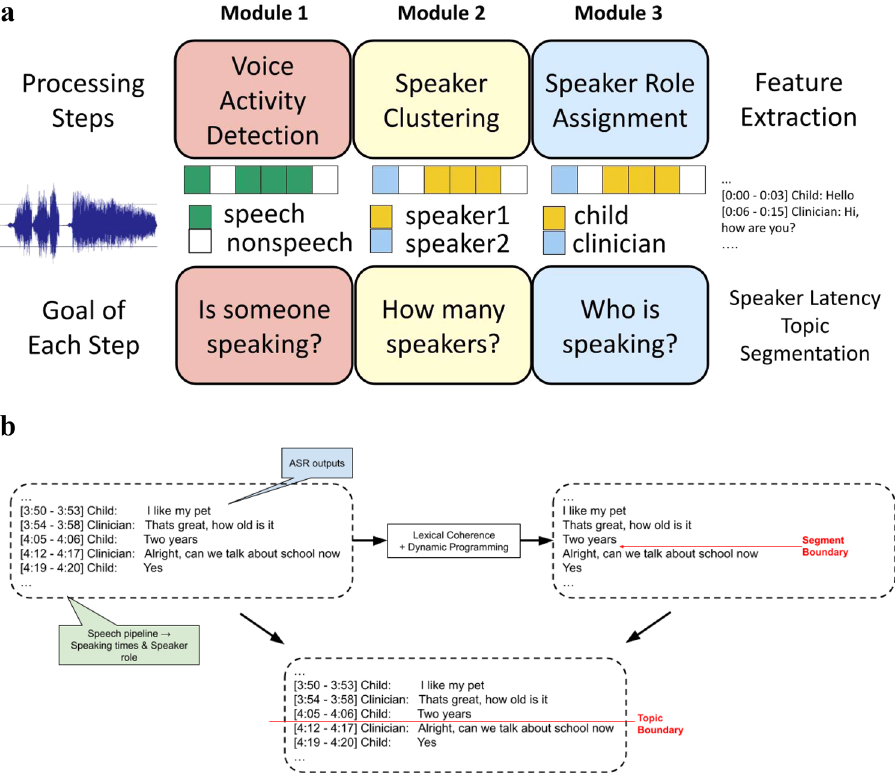
Figure 2. ( a ) Automated speech processing pipeline. Processing steps are depicted in the top row, with the goal of each step depicted in the bottom row. ( b ) Identification of topic boundaries. Topic boundaries (topic start and topic end) were computed automatically using the outputs from automatic speech recognition (ASR) system. Dynamic programming was used to divide the ASR transcript into contiguous